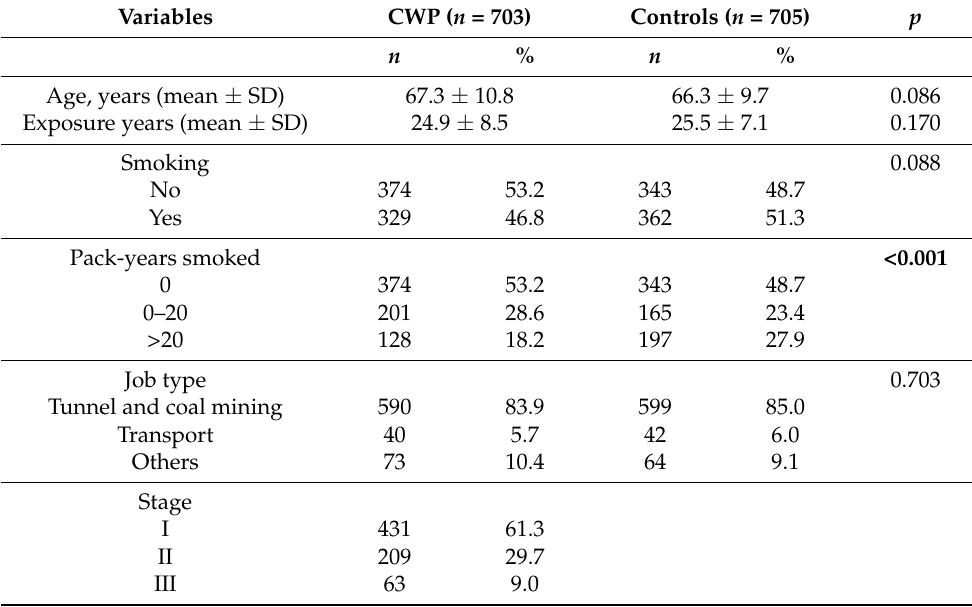
Table 1. Demographic and selected variables among the coal workers’ pneumoconiosis (CWP) cases and controls.